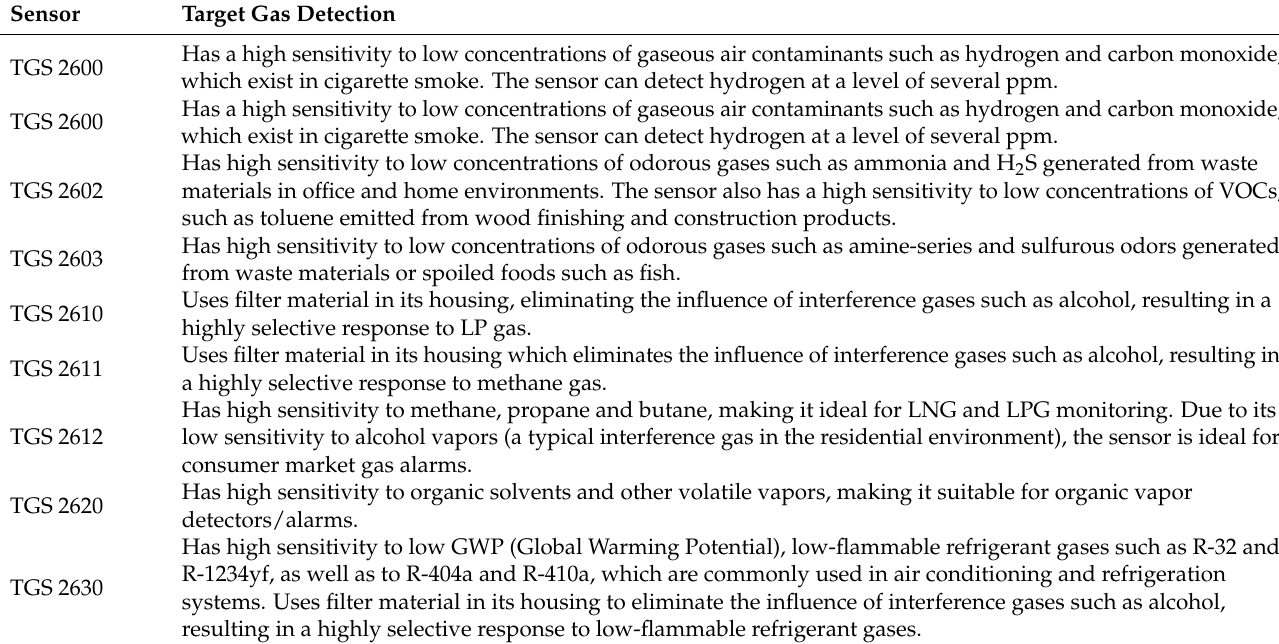
Table A1. List of sensor models used in our electronic nose device and target odors and